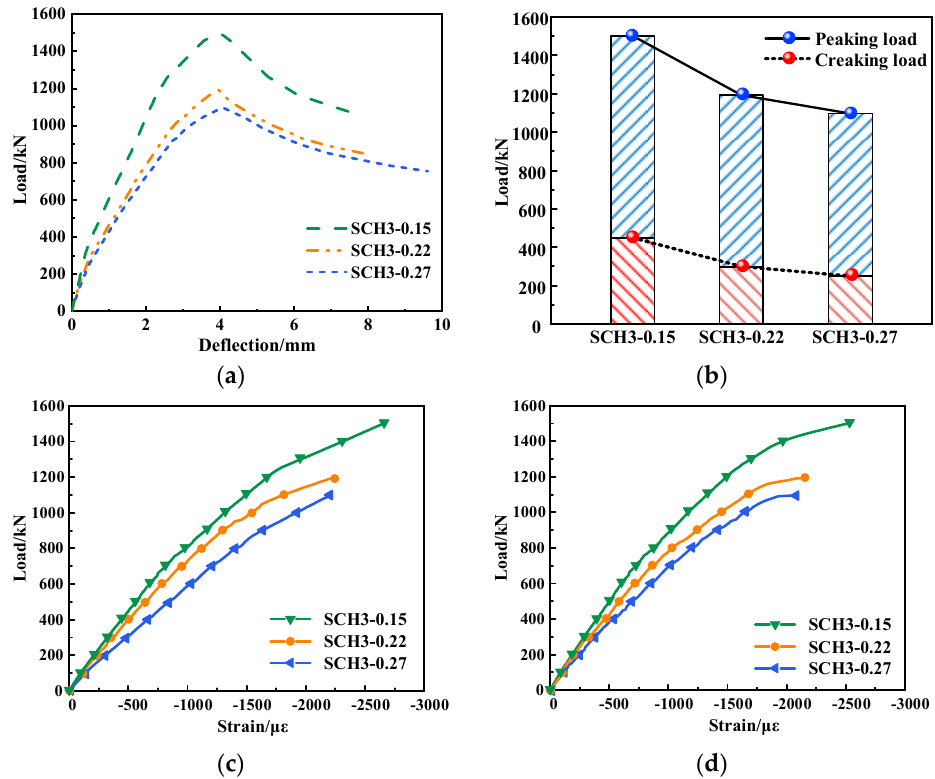
Figure 16. Comparison of specimens with different longitudinal steel strand reinforcement ratios. ( a ) Load-midspan lateral deflection curve; ( b ) Cracking and peaking load variation curves; ( c ) Load- ECC compressive strain curve; ( d ) Load-longitudinal bar compressive strain curve.